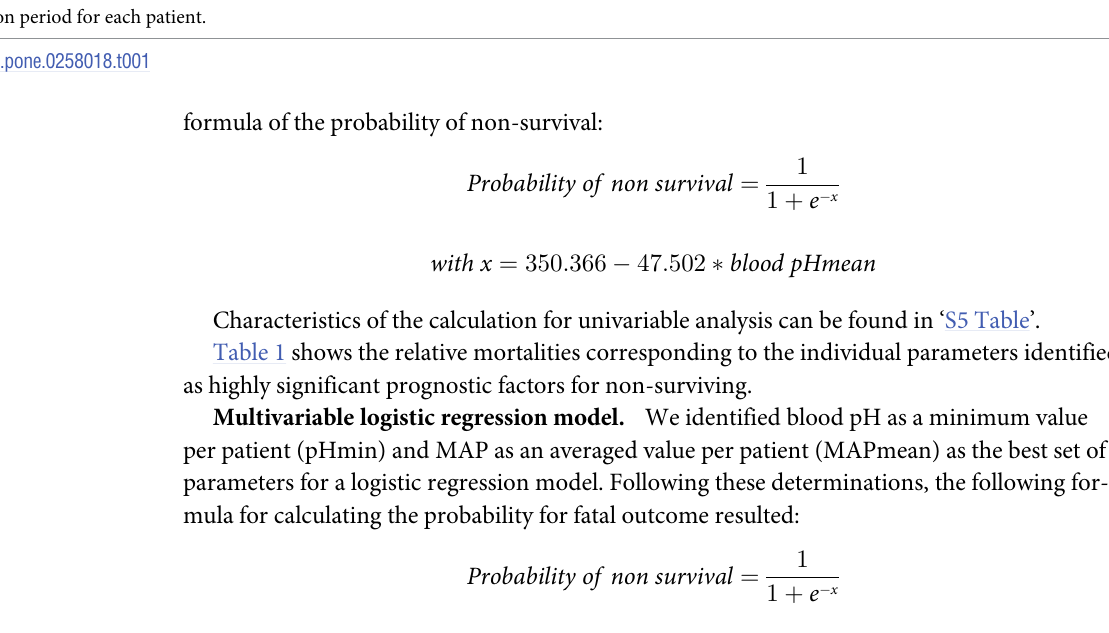
MAPmean, mean MAP during the 14-day observation period for each patient; pHmean/pHmax/pHmin, mean, maximum and minimum blood pH during the 14-day observation period for each patient; BEmean/BEmax, mean, maximum BE during the 14-day observation period for each patient; Troponin Tmean, mean troponin T during the 14-day observation period for each